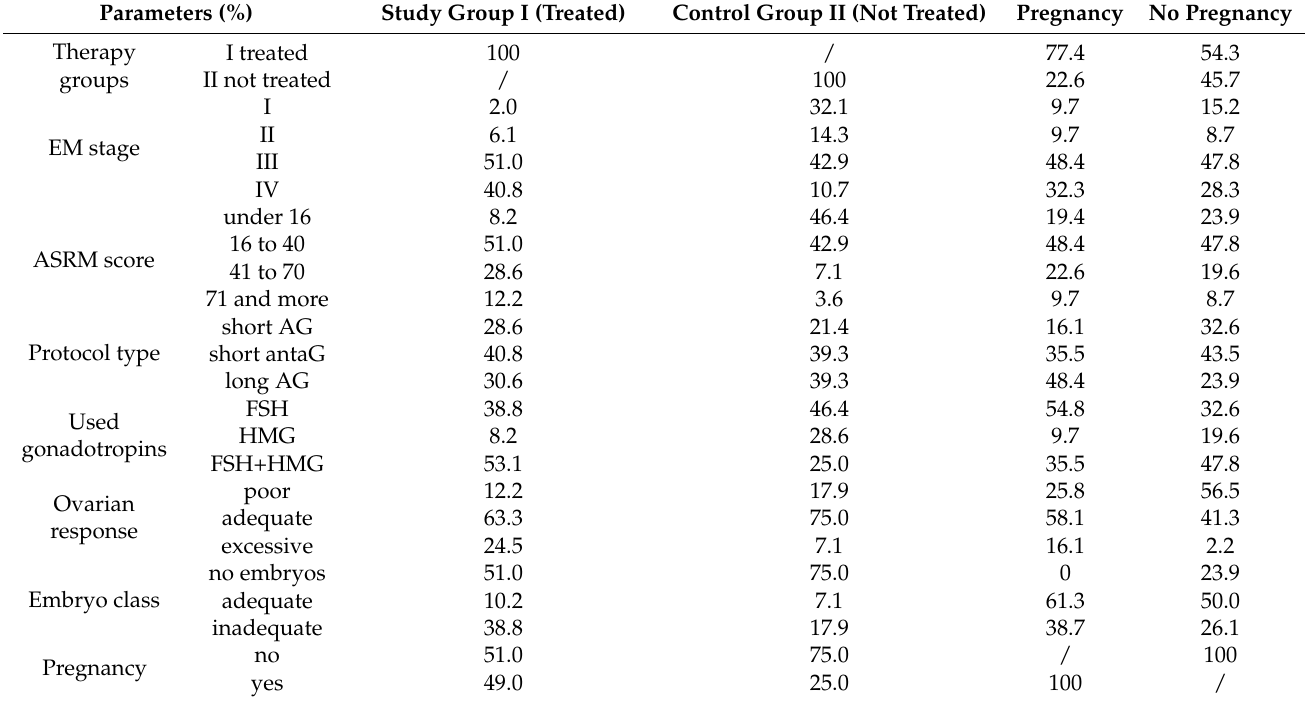
Table 2. Frequency (%) of the assessed parameters according to the examined